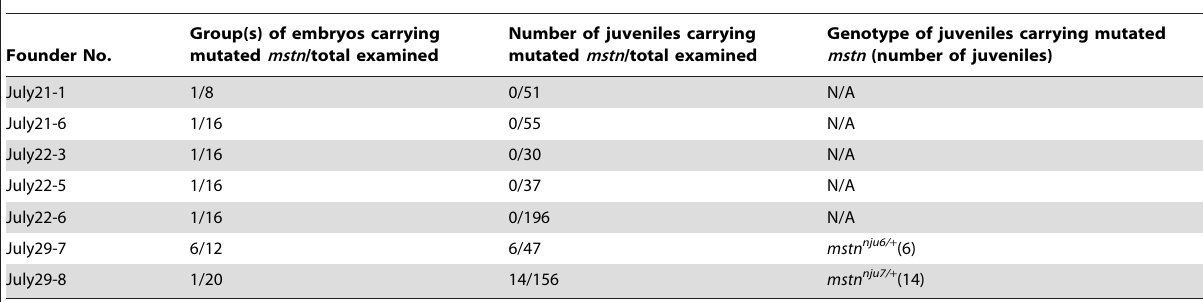
Table 2. Summary of the identification of the yellow catfish carrying disrupted mstn .